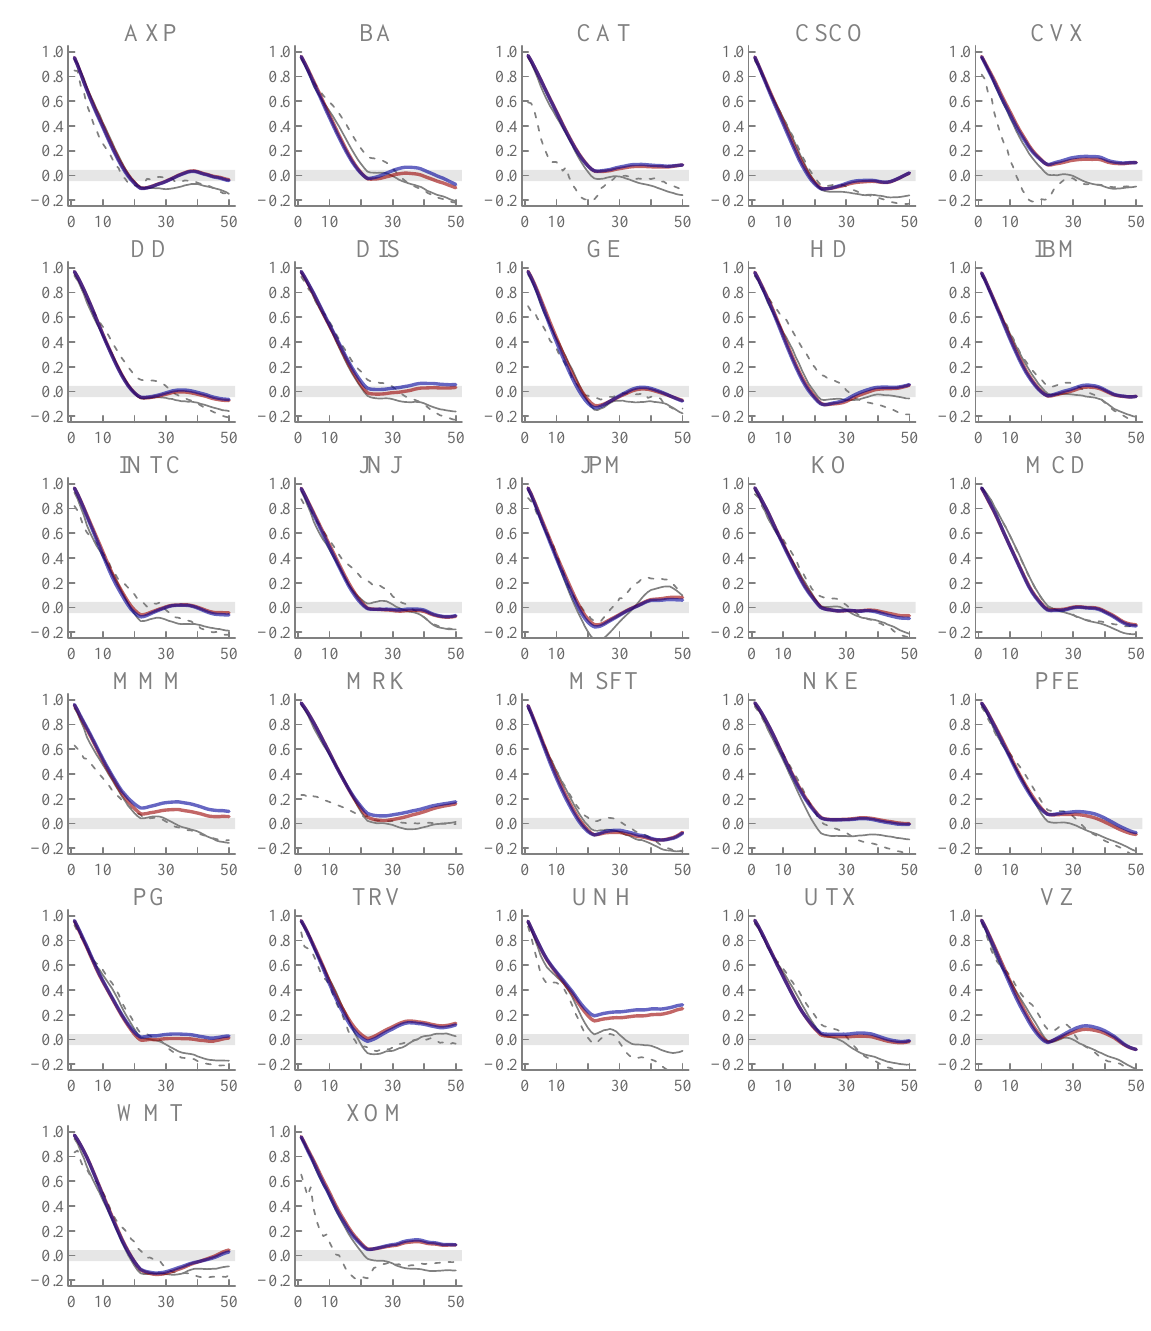
− (cid:98) y ( h ) Figure A4. Autocorrelations of forecast errors e t = y h for stepsize h = 22 days. The autocorre- √ t t RV (gray), for HARQ with y = RV (dashed gray), and for RQ -in-mean lations for HAR with y = √ RV (blue) should all be white noise if e t is iid . with log of average RV (red) and with log of average The gray shaded area is the two standard error band for a white noise series. The rolling forecasts are generated with a rolling estimation window of 8.67 years (104 months) followed by a one month prediction window shifted each month over 96 windows. The forecast sample is from 3 January 2006 to 31 December 2013 (2013 trading